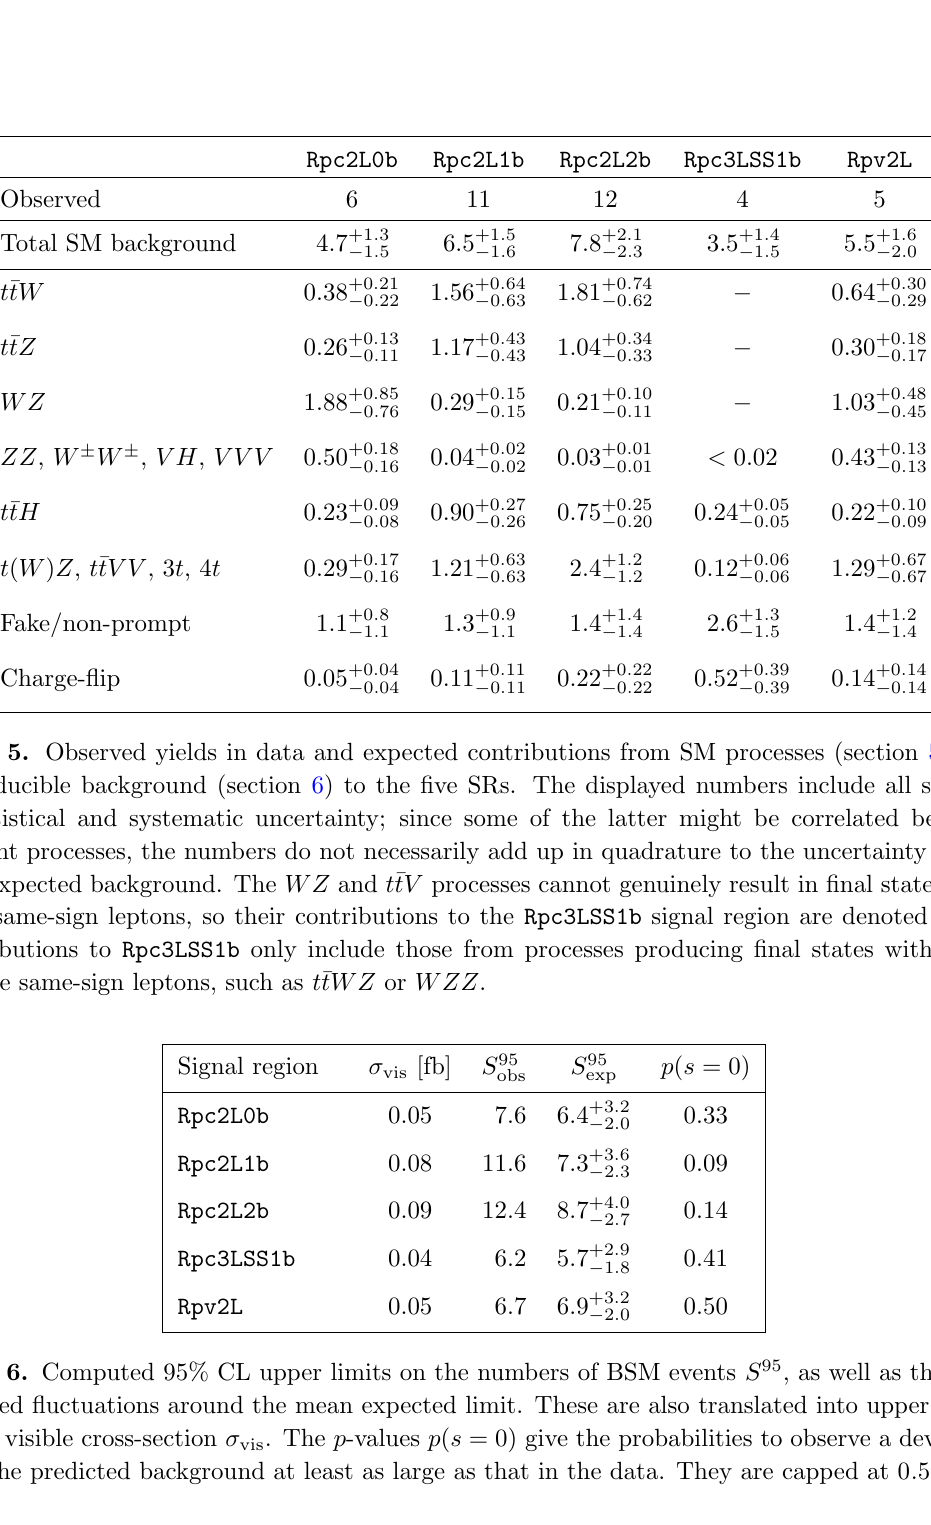
Upper limits at 95% con(cid:12)dence level (CL) on possible BSM contributions to the SRs are computed with the HistFitter framework [83], relying on a pro(cid:12)le-likelihood-ratio test